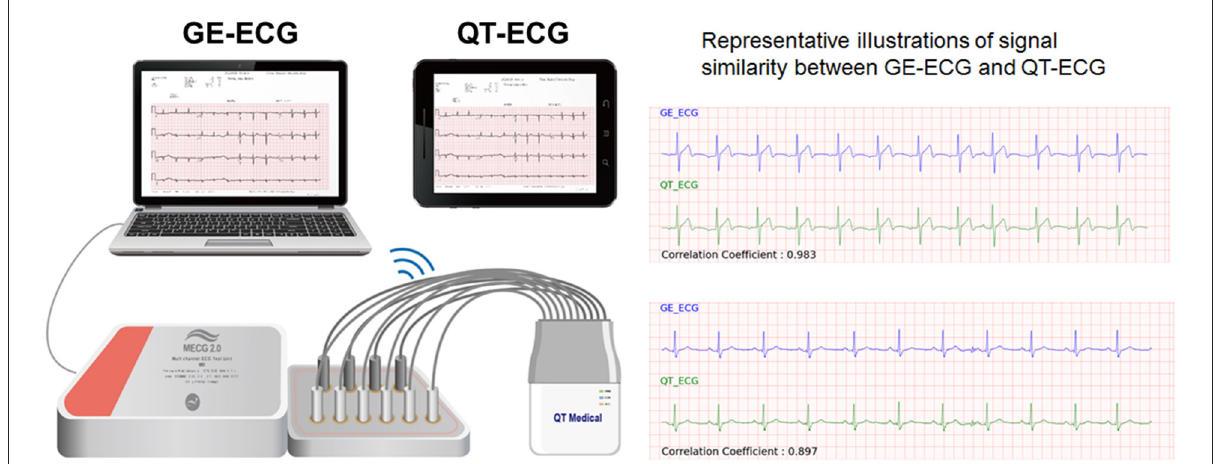
FIGURE3 Validation of 12-lead ECG signals between devices. The proposed deep learning model for STEMI detection was based on the digital 12-lead ECG signals recorded using a computerized ECG machine (GE Healthcare MAC 2000/3500/5500, USA). For the prehospital 12-lead ECG acquisition in the current study, we used a mini portable ECG device (QT Medical, Diamond Bar, CA, USA) with the proposed AI algorithm integrated within. To ensure the efficacy of AI-based STEMI detection using the mini-portable ECG device, we checked the consistency of the 12-lead ECG output signals between the two devices. A total of 194 verified ECGs acquired from GE machines (GE-ECGs) were converted into the corresponding QT Medical ECG output format (QT-ECGs) using a certified ECG simulator. Finally, the signal similarities between raw GE-ECGs and the transcribed QT-ECGs was analyzed. The performance of the AI model in classifying data as “STEMI” or “Not STEMI” for each of the two sets of ECG signals was compared to attest to the consistency of AI performance across